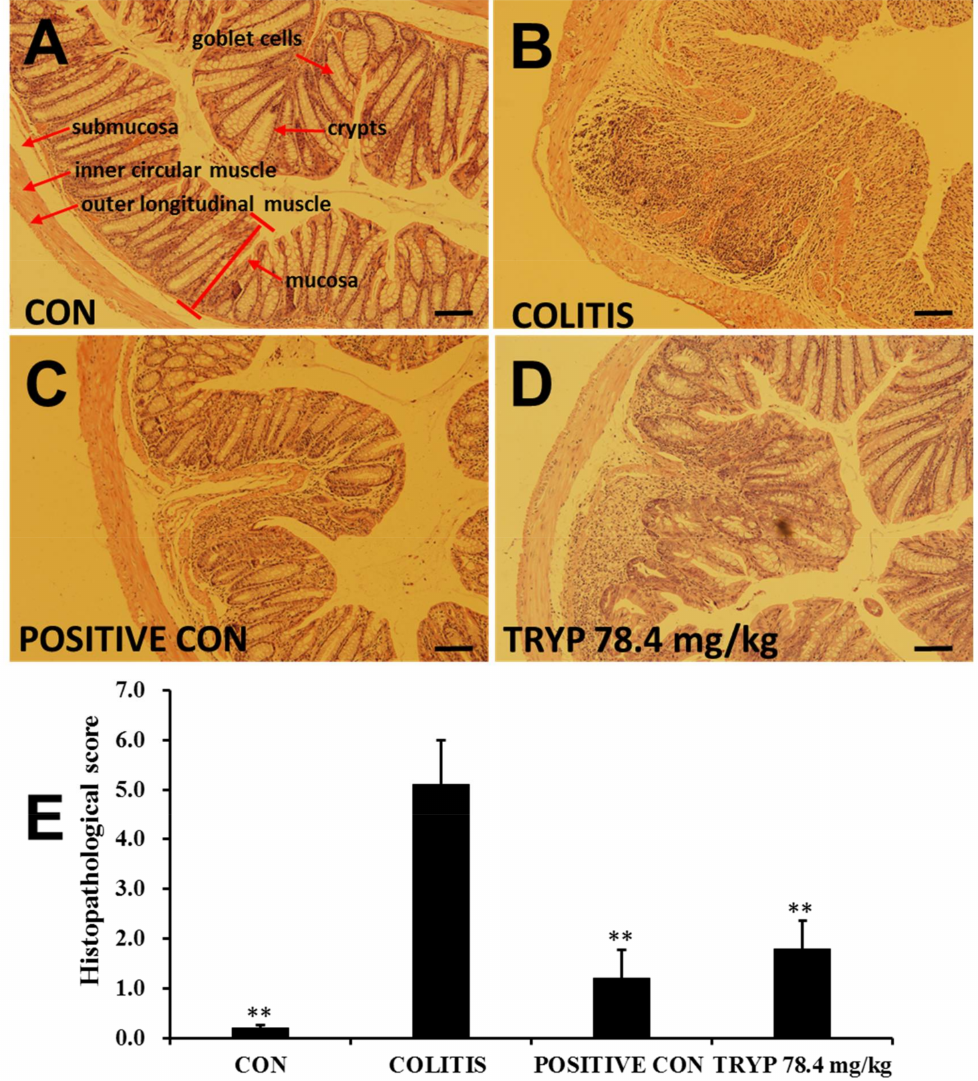
Figure 4. Histologic characteristics of each group, magnification × 100. ( A ) Normal colonic mucosa with regularly formed colonic folds covered by intact mucosa. ( B ) The histologic characteristics of colitis group. Inflammatory cell completely infiltrated to mucosa and submucosa. ( C ) The histologic characteristics of sulfasalazine control group. ( D ) The histologic characteristics of TRYP group with a concentration of 7.84 mg/kg. ( E ) The sum of histological score obtained from blinded histopathological analysis. Error bars represented means ± SEM of n = 3, ** p < 0.01 compared with